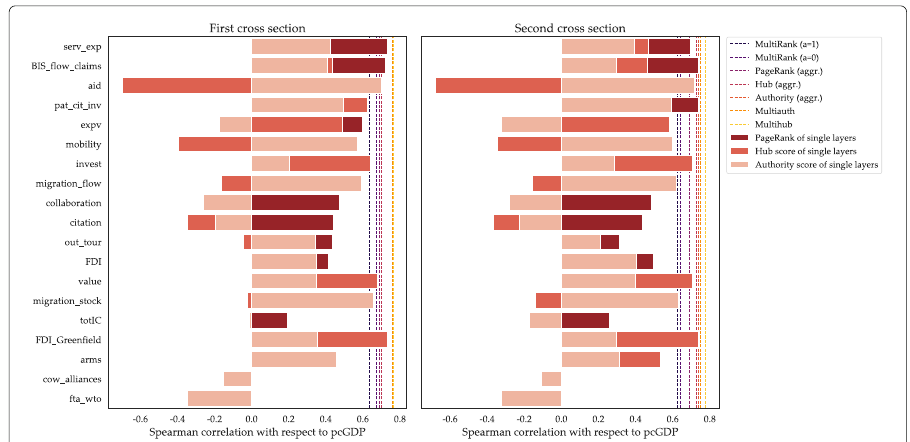
Fig. 7 Performance of single layers centrality measures (stacked barplots) against multiplex ones (dashed lines) evaluated by correlation of their ranking of nodes with respect to